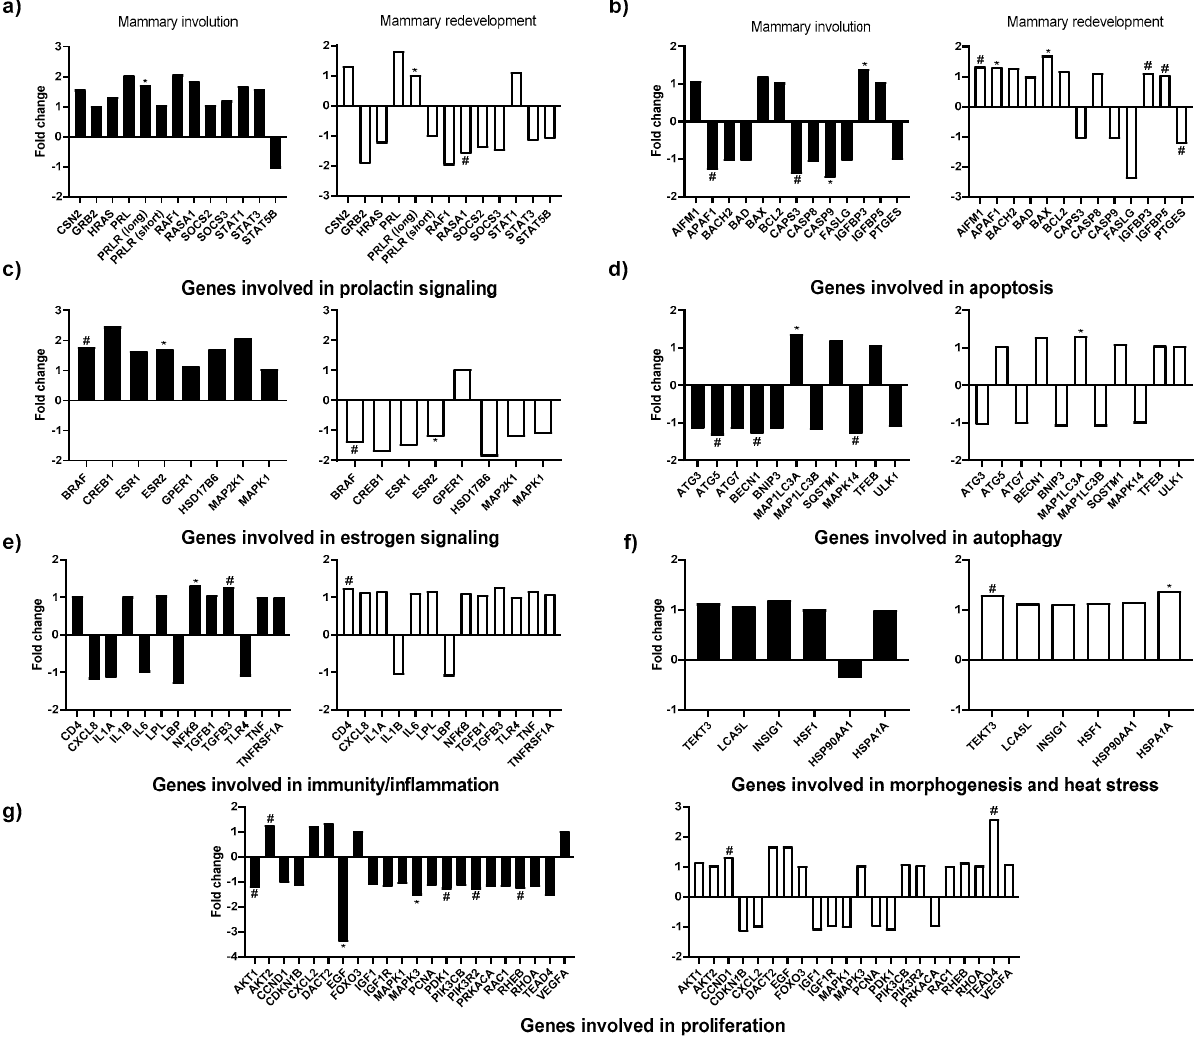
Figure 4. Gene expression in mammary gland tissue explants of heat-stressed dairy cows (HT) or cows provided active cooling (CL) during the dry period. Explants were collected during early involution (black columns, 3 d after dry off) and during mammary growth (white columns, 35 d after dry off) phases. Gene expression is reported as fold change (2- ΔΔ Ct) relative to cooled cows. An asterisk (*) indicates significant differences ( p ≤ 0.05) and (#) indicates tendencies (0.05 < p ≤ 0.15) between HT and CL treatments. Letters a to g refer to the gene function of interest.